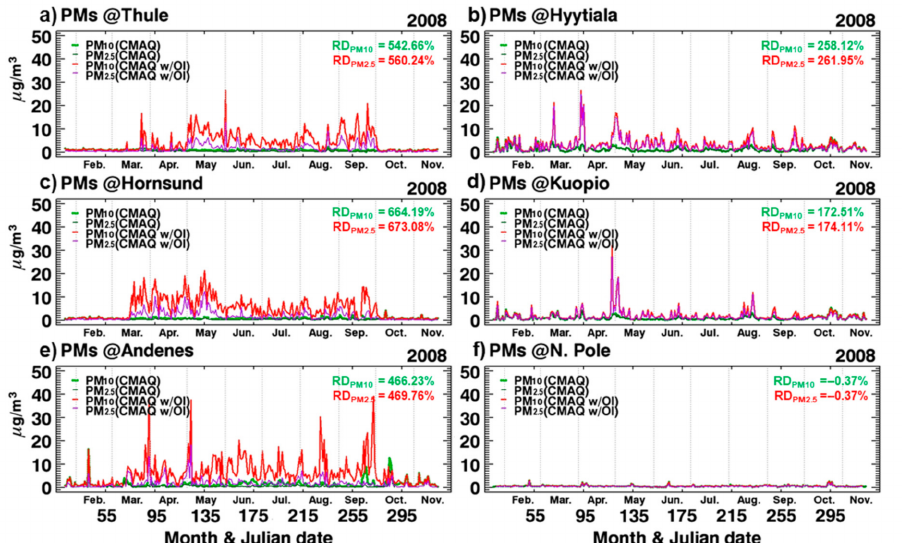
Figure 6. Temporal variations of the modeled (bright and dark green lines) and estimated (red and purple lines) PM 10 and PM 2.5 at ( a ) Thule, ( b ) Hyytiala, ( c ) Hornsund, ( d ) Kuopio, ( e ) Andenes, and ( f ) the North Pole. The RD (relative differences) of PM 10 and PM 2.5 were also calculated at each station from following equations of RD PM10 = (PM 10,CMAQw/OI –PM 10,CMAQ )/ PM 10,CMAQ and RD PM2.5 = (PM 2.5,CMAQw/OI –PM 2.5,CMAQ )/ PM 2.5,CMAQ